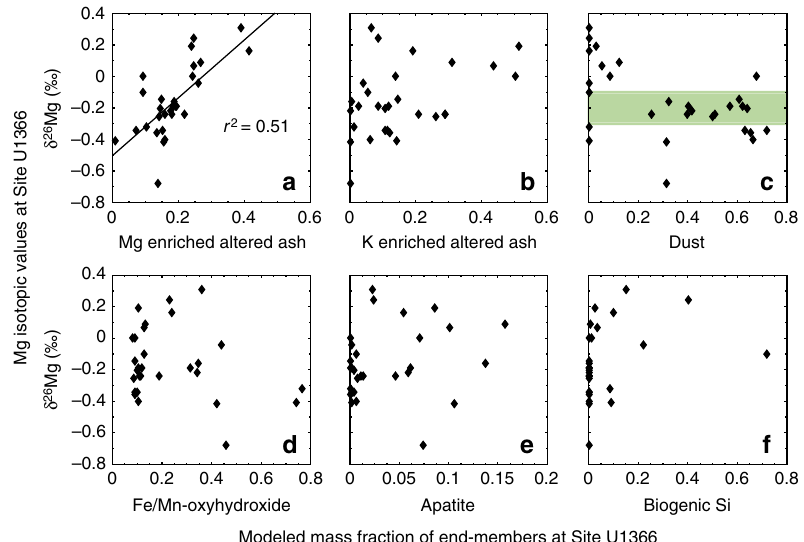
Fig. 2 Comparison of two techniques that identify authigenic clay at Site U1366. Measured δ 26 Mg ( ‰ , all y -axes) values are plotted against the modeled mass fraction ( x -axes) for each of the six components of the bulk sediment ( a – f ). a The signi fi cant correlation ( r 2 = 0.51; P < 0.01) between δ 26 Mg and the mass fraction of Mg-enriched altered ash is consistent with heavier Mg isotopes being incorporated from seawater into an authigenic clay component. c Samples with a high mass fraction of dust plot near the δ 26 Mg values typical of bulk-silicate earth ( green shaded region ), further indicating consistency between the two